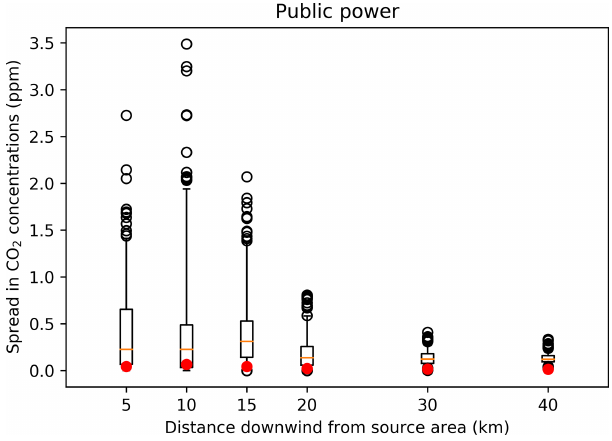
Figure 11. Spread in simulated concentrations of CO 2 resulting from public power emissions due to differences in the proxy map: emissions are distributed using the new proxy map with only 20 ran- domly chosen pixels containing emissions. The box represents the interquartile range, the whiskers the 2.5–97.5 percentiles, the lines the median values, and the black circles are outliers of the full en- semble. The red dots show concentrations of CO 2 when the original proxy map is used (industrial area).